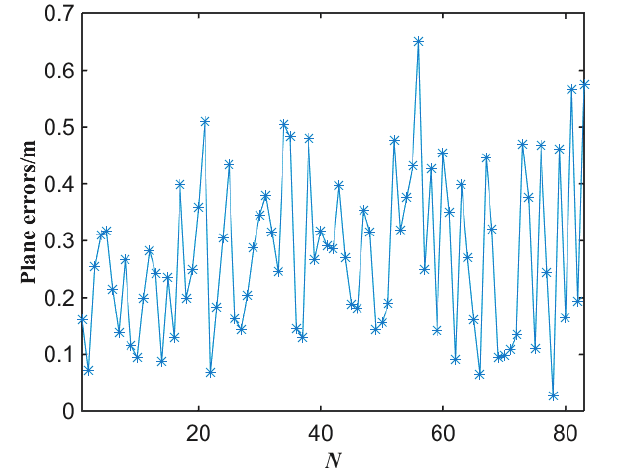
Figure 15. The error of plane localization with the miner’s lamp video collaborative